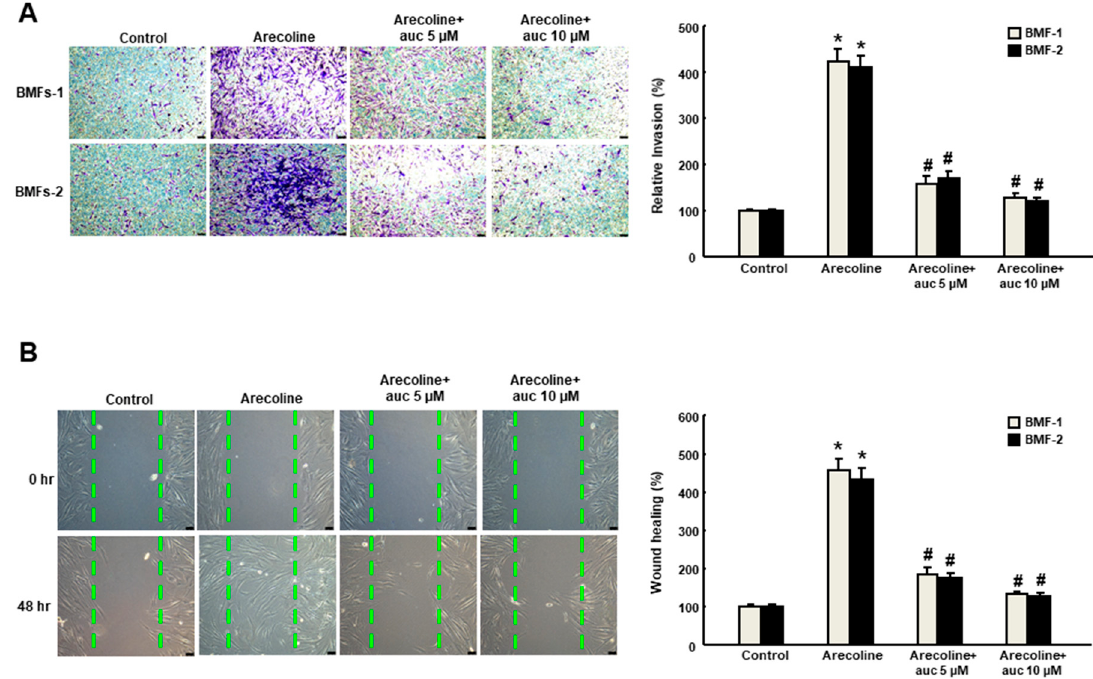
Figure 3. Arctigenin downregulates the arecoline-stimulated invasion and wound healing activities of BMF. Arecoline-treated BMF were subjected to ( A ) invasion or ( B ) wound healing assays in the presence of various concentrations of arctigenin. The experiments were repeated three times, and representative results are shown. The results are means ± SD. * p < 0.05 as compared with the non-arctigenin-treated group. # p < 0.05 as compared with the arecoline group. Magnification, × 100. The green dot line define the areas of wound healing